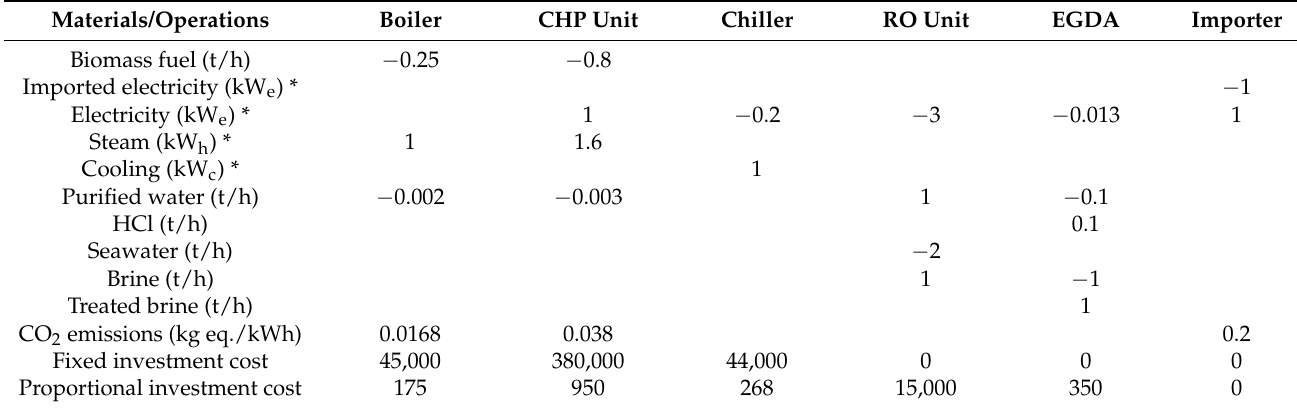
Table 2. Mass and energy balance and parameters of cost for the operating units considered for synthesis of polygeneration plant.